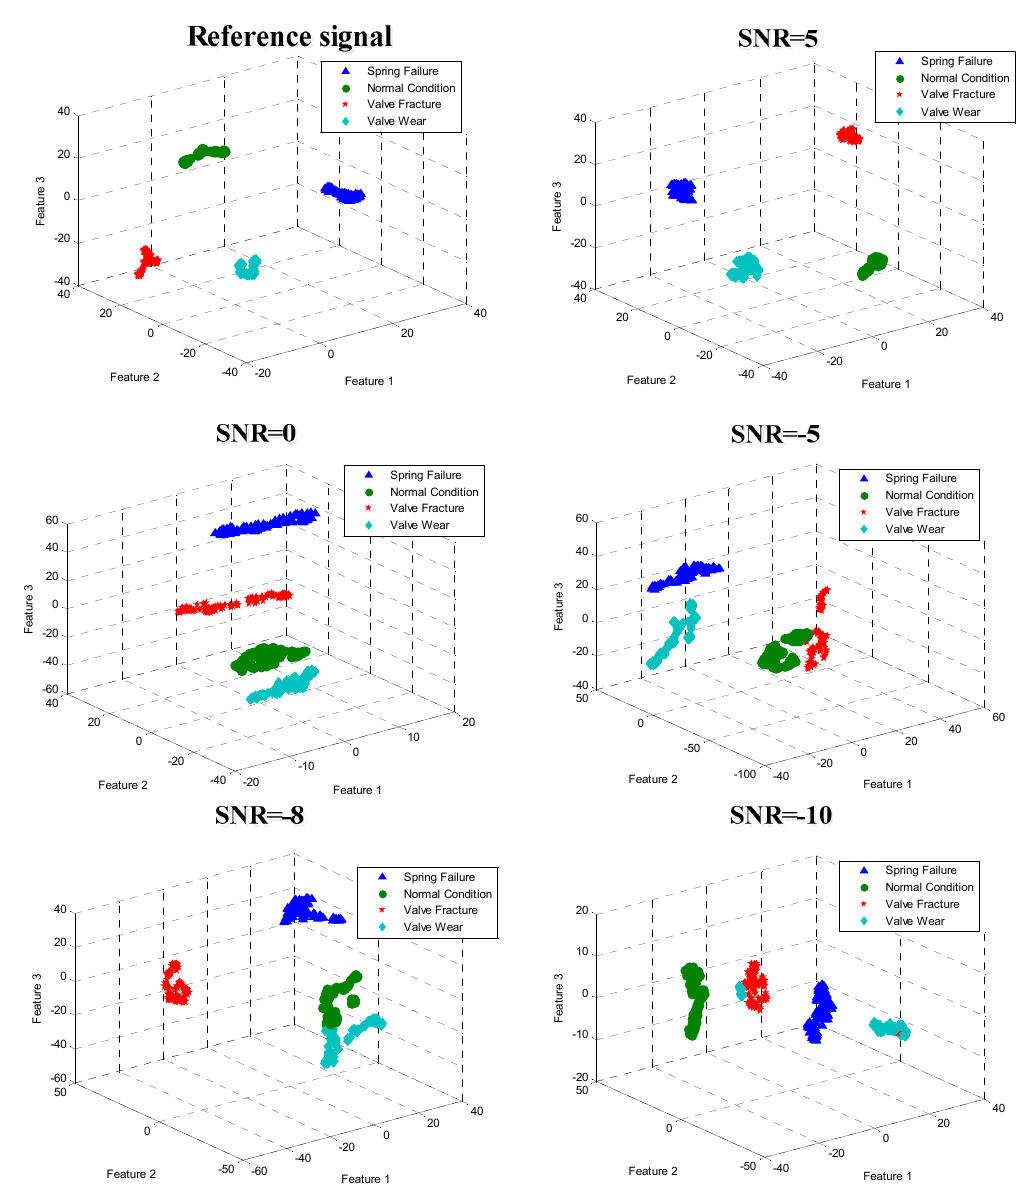
Figure 9. Feature extraction of different noise signals.